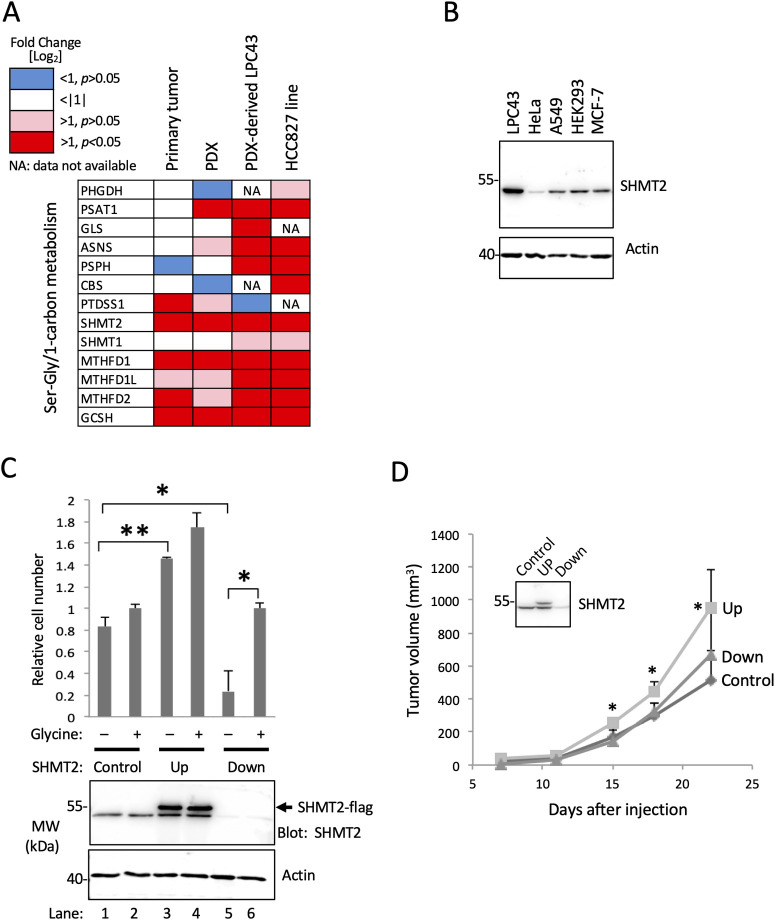
Expression of one carbon metabolism proteins in a lung tumor and derived models and effect of modulated SHMT2 expression.(A) Comparison of expression of SHMT2 and proteins involved in one-carbon metabolism in indicated tissue and cell lines. Protein intensities were analyzed by MS and quantified by using MaxQuant software. Protein expression in the four indicated samples were normalized with a control protein (HIST2H3A) and then compared to levels measured in normal lung tissue; (B) Endogenous SHMT2 expression in five indicated cell lines. Western blotting was carried out with the indicated antibodies. (C) Histogram showing effect of SHMT2 protein expression on HeLa cell proliferation. HeLa-Ss cells were induced for ectopic expression of SHMT2-Flag (Up) or shRNA-mediated knockdown of endogenous SHMT2 (Down). Cells were tested in synthetic medium lacking glycine and containing dialyzed (glycine-free) serum, and supplemented without (–) or with (+) 100 mM glycine. The aligned anti-SHMT2 western blot (lower panel) shows protein expression of ectopic and endogenous SHMT2 (as indicated), and expression actin as an indication of equal protein loading. (D) Effect of SHMT2 expression on tumor growth in vivo. SCID mice bearing HeLa-Ss cells with induced expression of SHMT2-Flag (UP) or shRNA-SHMT2 (Down) were monitored for xenograft tumor growth. Mean tumor volumes (± SD) for each group (n = 4 or 5) are shown. The inserted box is a representative western blot of three tumor samples confirming changes in SHMT2 protein levels as indicated.